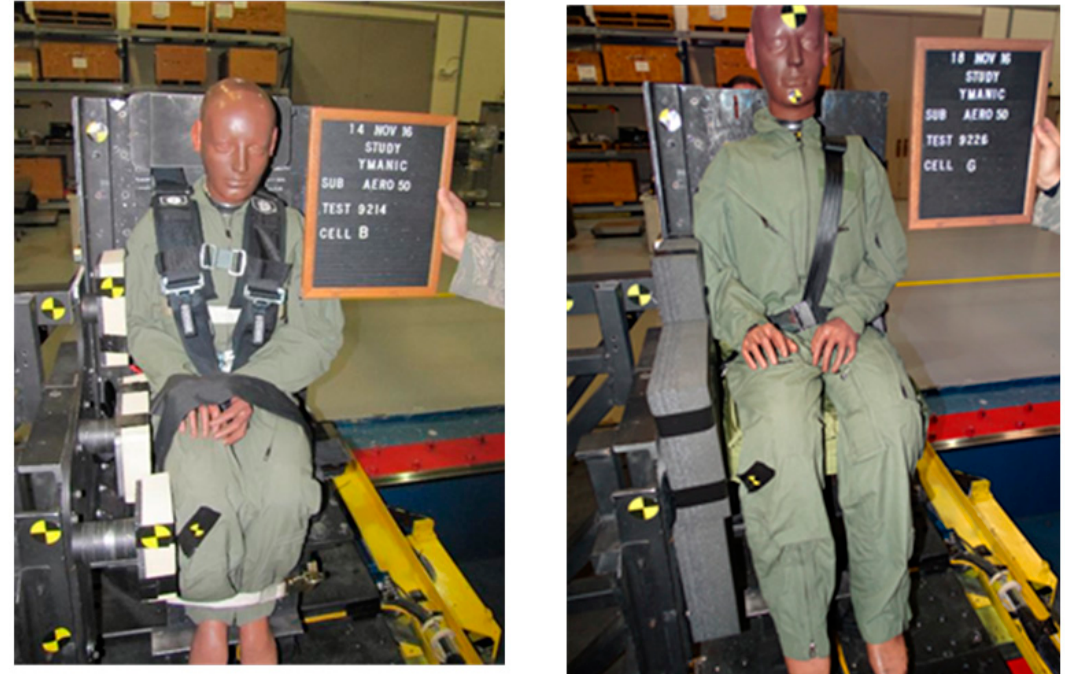
Figure 2. Padding and restraint systems used with the impact seat. The “rigid seat” configuration is on the left, showing the high-density felt on the side-impact plate, and the ATD in a 5-point restraint. The “padded seat” configuration is on the right showing the soft foam on the side-impact plate, and the ATD sitting on the 5-inch-thick seat cushion and with a 3-point restraint.